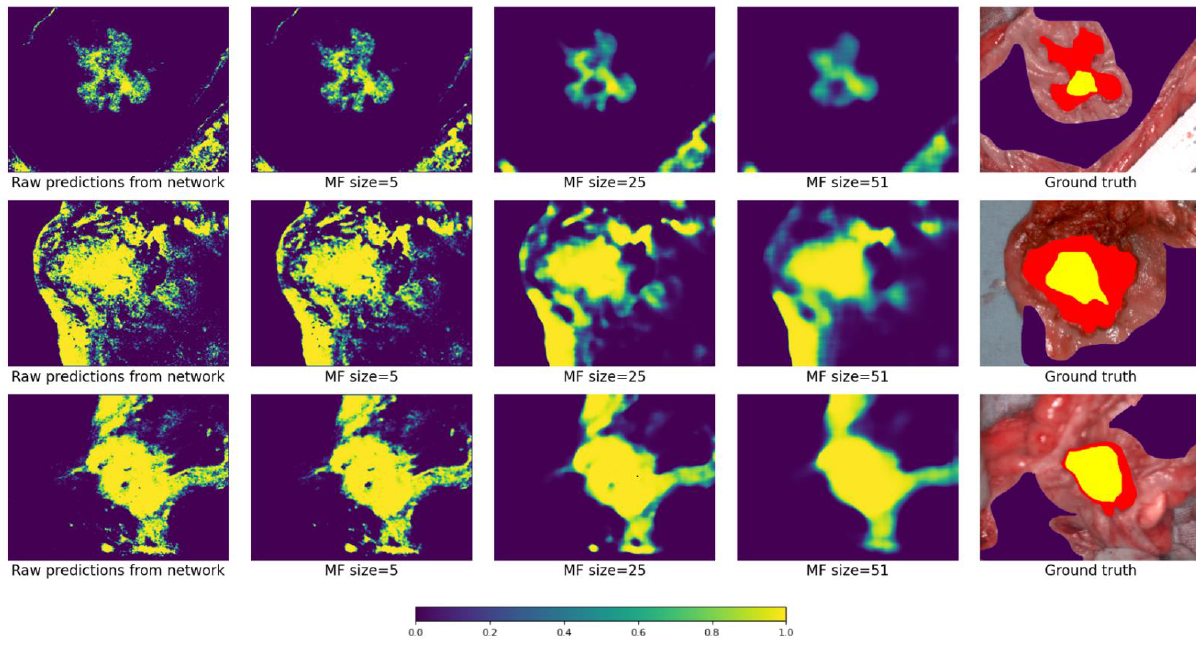
Figure 15. How different MF sizes affect the output. Color scheme as in the previous figure.